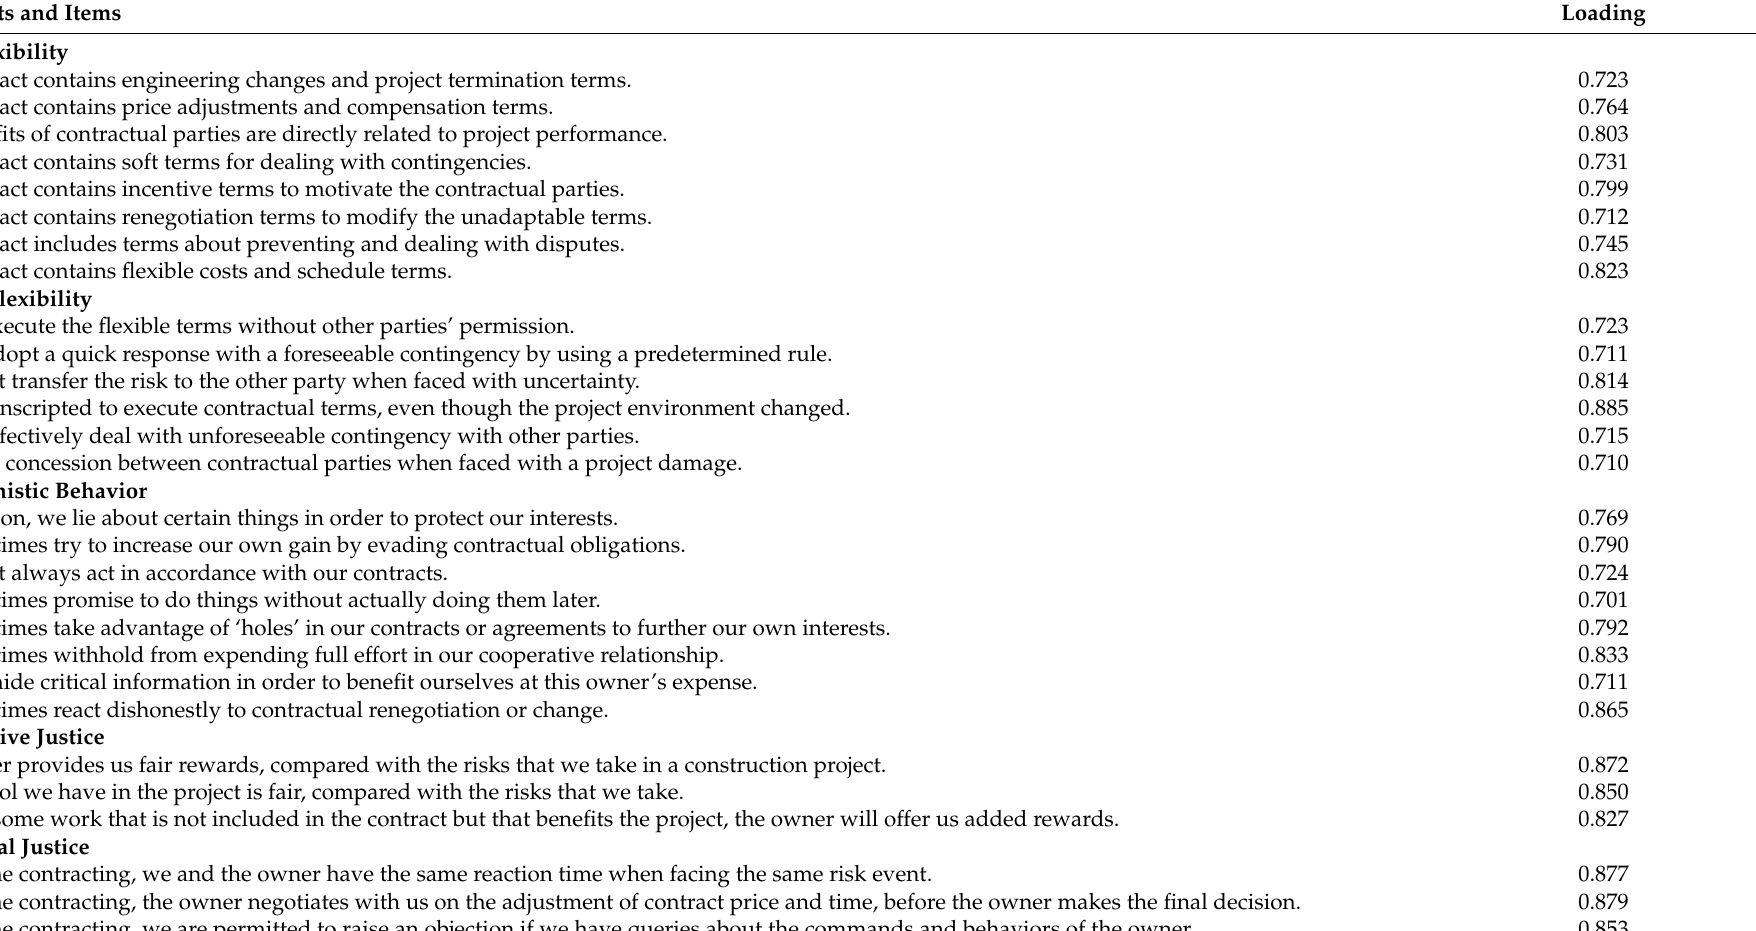
Table 2. Constructs items and factor